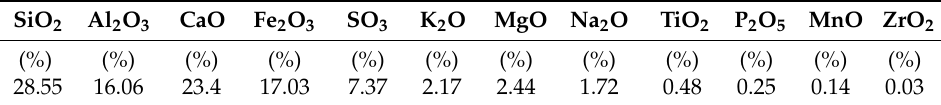
Table 5. Chemical compositions of fly-ash determined by X-Ray Fluorescence